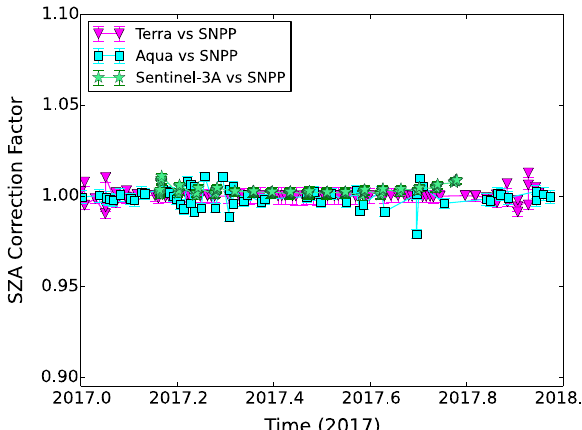
Figure 4. Solar zenith angle (SZA) correction factors in the year 2017 for Terra versus SNPP satellite (magenta triangles), Aqua versus SNPP satellites (cyan squares), and Sentinel-3A versus SNPP satellite (green stars) demonstrating stable trends.